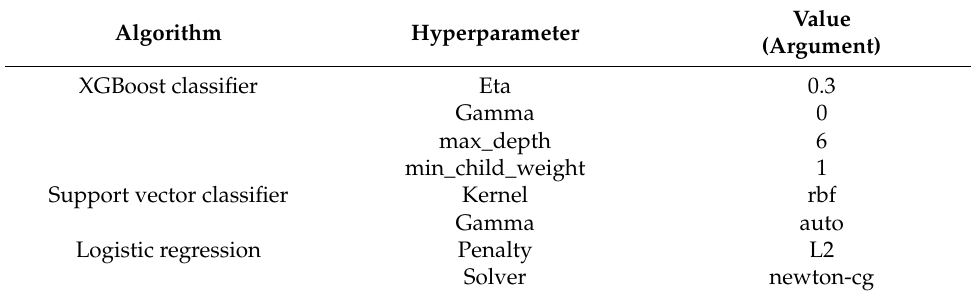
Table 4. Hyperparameters applied in the machine learning